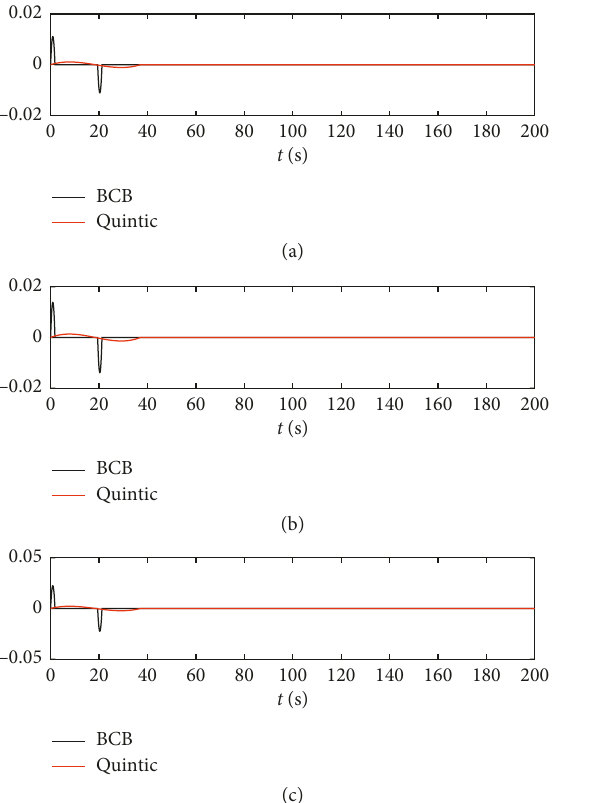
Figure 4: Time response of planned angular acceleration.